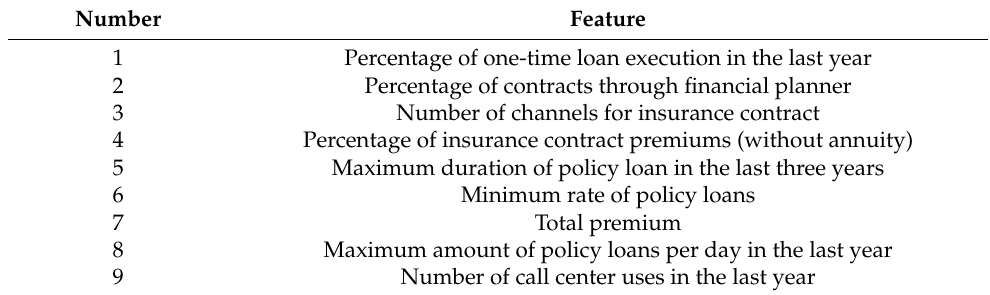
Figure 8. The number and percentage of intersections important features of ML and DL models according to the top N percent of feature importance. Table 10. List of important variables in both ML and DL based on top 20% of feature importance.